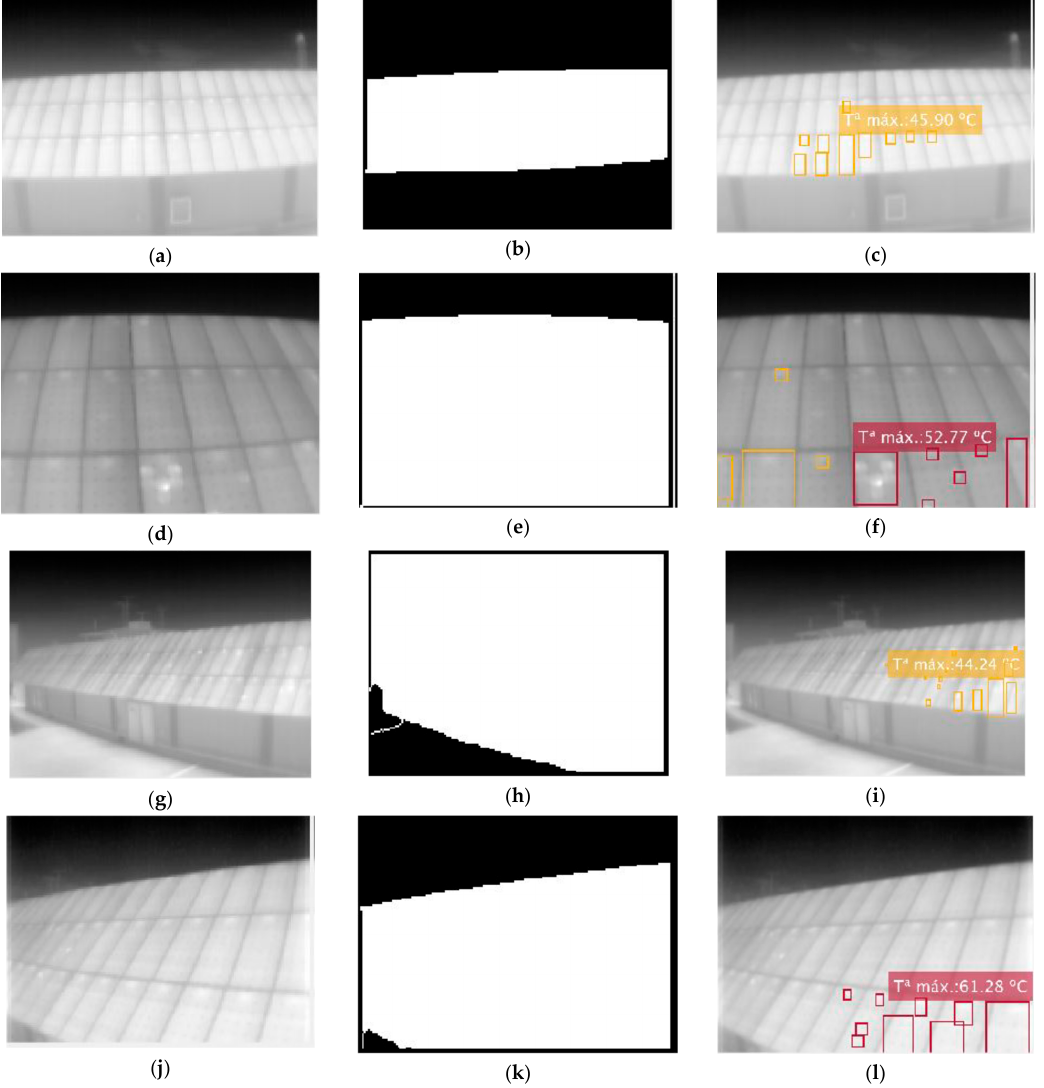
Figure 16. Different thermographies maintaining position and angle for distance comparison. ( a , d , g , j ) Raw images; ( b , e , h , k ) segmented images; and ( c , f , i , l ) final image. Therefore, it can be stated that at a greater distance, there is no loss of effectiveness in recognizing the area of interest, but the temperature measurement is impaired due to the low geometric resolution.